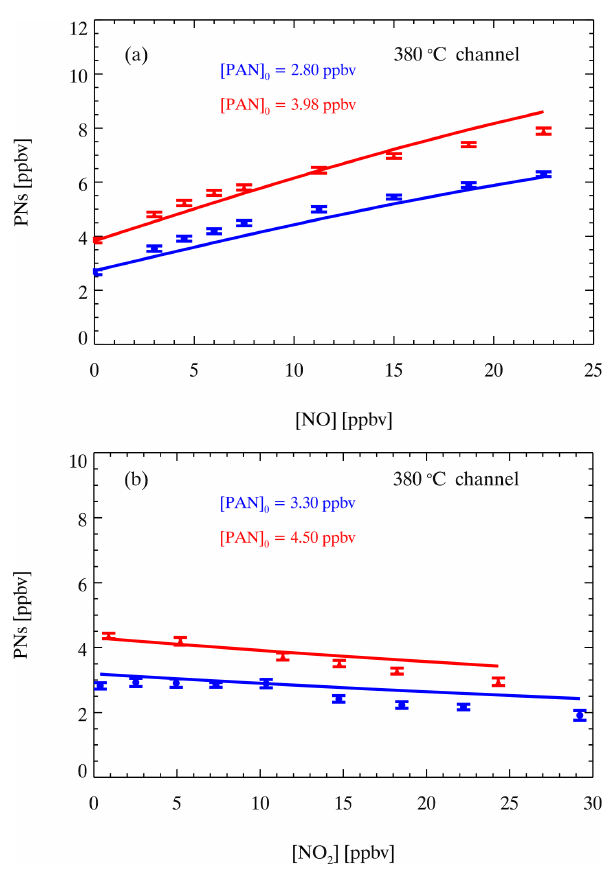
Figure 10. Simulated (lines) and measured (points) differences be- tween the NO 2 signal in the AN channel and reference channel for different PAN sources with different amounts of NO (a) and NO 2 (b) . The error bars show 1 standard